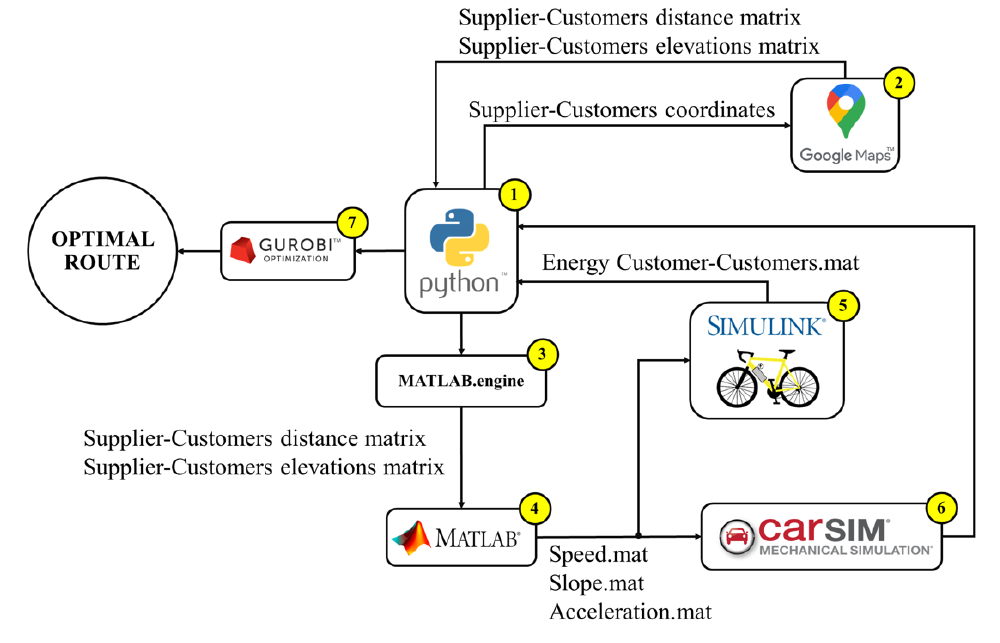
Figure 1. Procedure scheme for optimal route